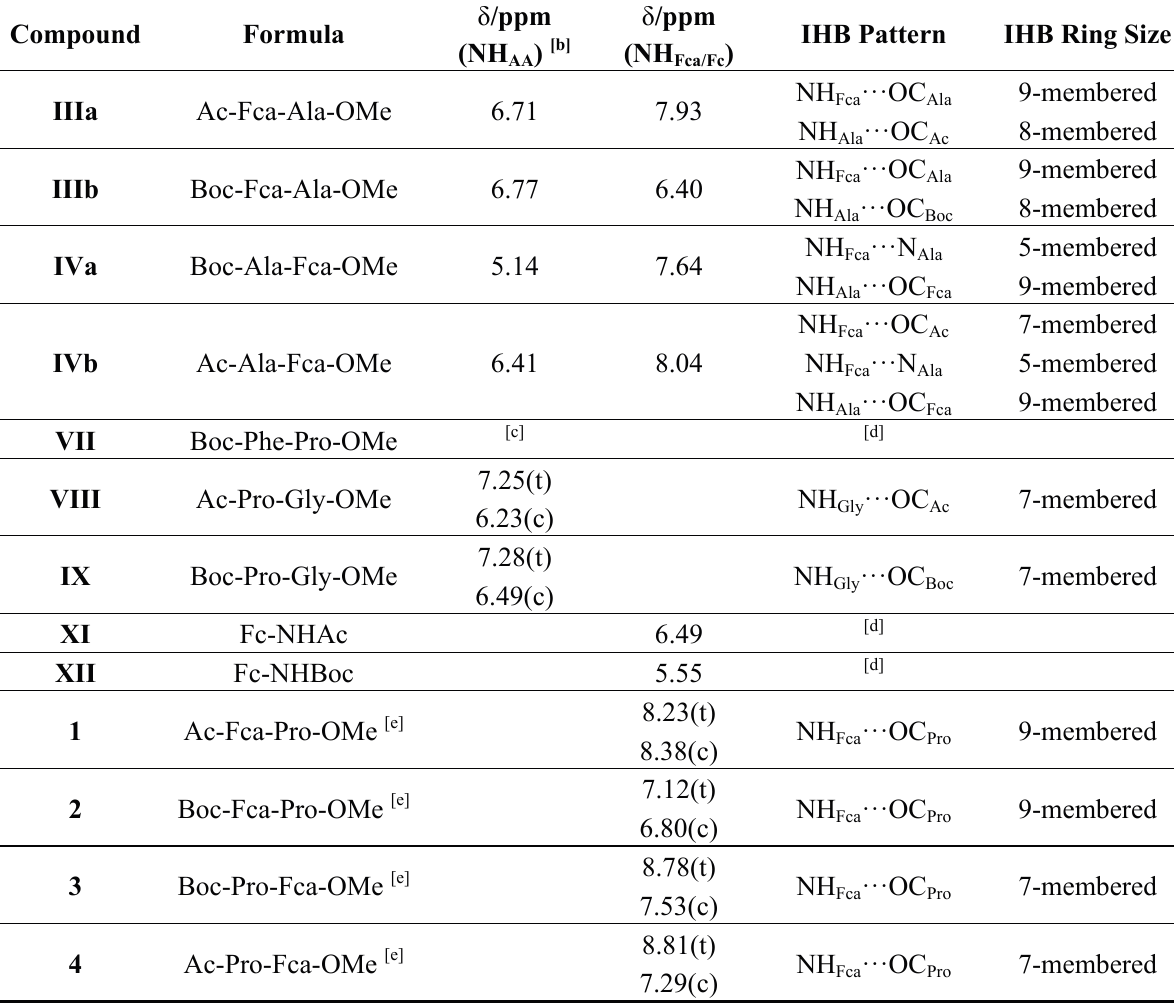
Table 4. 1 H-NMR chemical shifts [a] of the NH protons (ppm) of a model ( III , IV , VII-IX ), a reference ( XI , XII ) and the goal compounds 1 – 4 . The proposed IHB patterns of a model and a reference compounds VII-XVI . The possible IHB patterns of the goal compounds 1 – 4